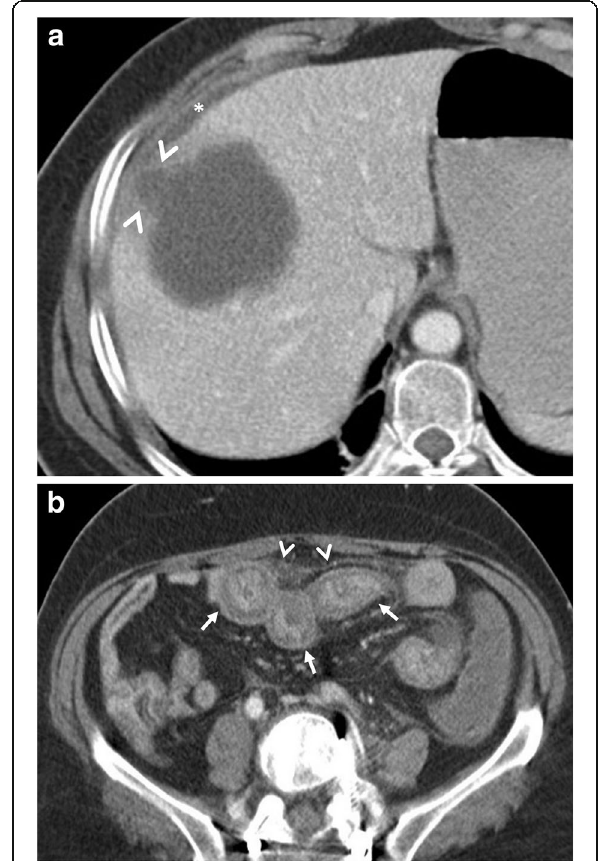
Fig. 5 A 16-year-old girl was admitted to the emergency department with an acute onset of right upper quadrant pain and fever. a Axial contrast-enhanced CT image demonstrates the imaging findings of intraperitoneal rupture of a hydatid cyst. Focal outward bulging found at the lateral wall of the cyst indicates the site of rupture (arrowheads, a ). Mild fluid collection adjacent to the hepatic capsule was also noted (asterisk). b Axial CT image from lower abdomen shows mural thickening of the jejunal loops (arrows) and adjacent fat tissue stranding (arrowheads) indicating the local allergic reaction of bowel wall secondary to ruptured hydatid cyst. Surgical findings confirmed the intraperitoneal rupture of the hydatid